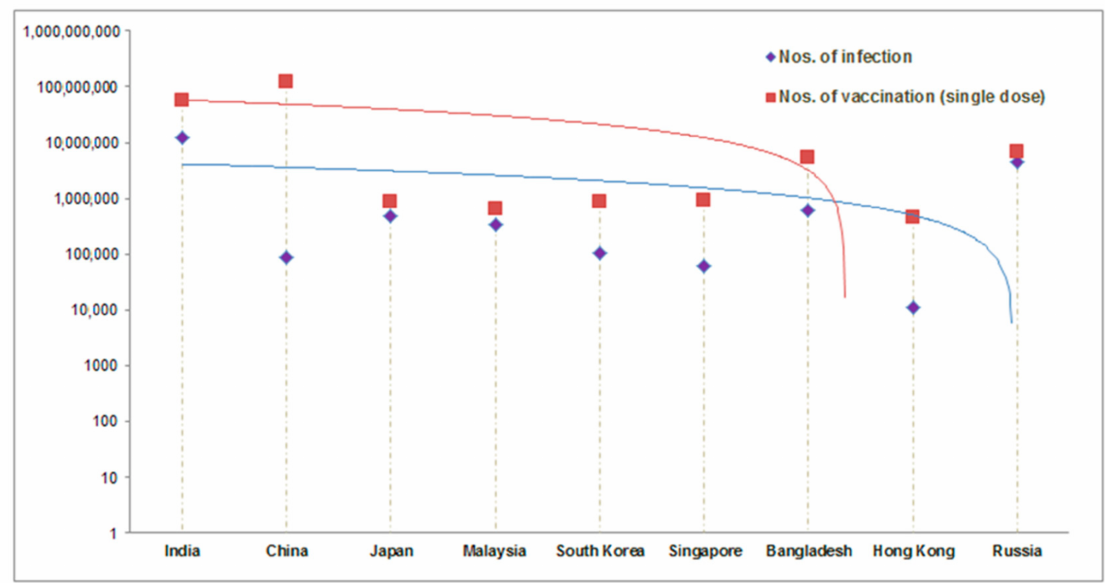
Figure 12. Comparison between the total no of infections and the vaccination status (in a single dose) in some Asian countries. It can help to understand R0 and the requirement of COVID-19 vaccination campaigns. (Data source: Vaccine Tracker, Statista, COVID-NMA, ClinicalTrials.gov, Biorender)